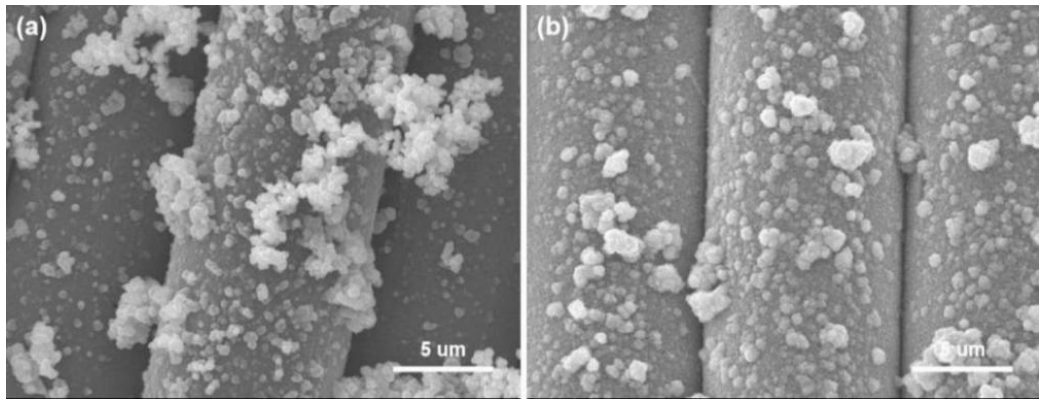
Figure 10. SEM images of Cu / Ag / PDA / PET fabrics before ( a ) and after ( b ) washing for 10 cycles.